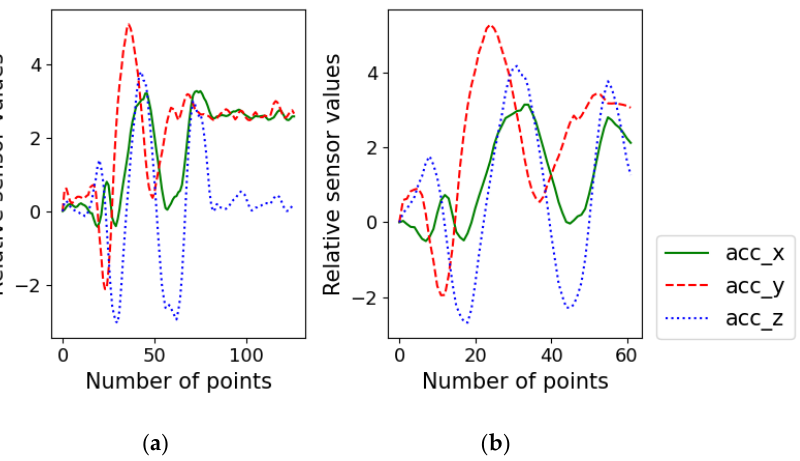
Figure 8. Example of non-movement region removal for Arabic numeral 9. ( a ) Accelerometer signal before the removal, ( b ) signal after the removal.